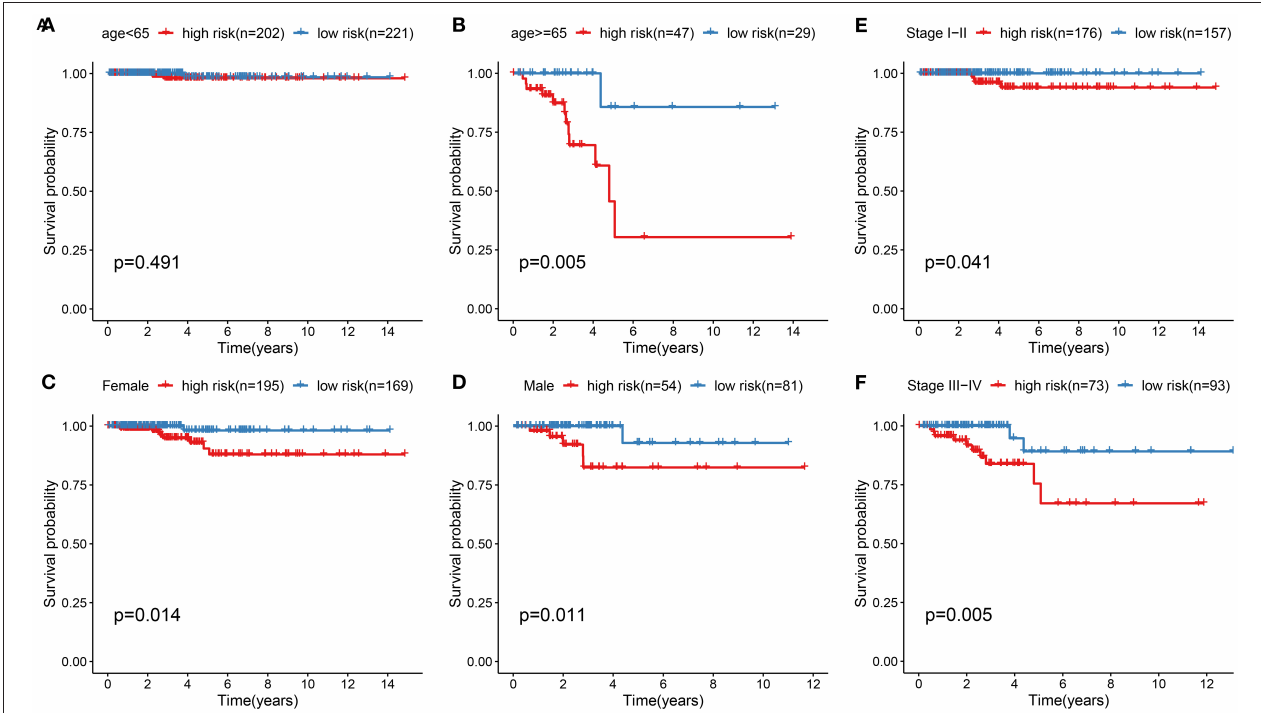
FIGURE 4 | Stratified analysis for the predictive efficacy of the ferroptosis-related model among thyroid cancer samples. (A,B) Kaplan-Meier curves for high and low risk group in the two subgroups of age < 65 and age ≥ 65. (C,D) Kaplan-Meier curves for high and low risk group in the two subgroups of female and male. (E,F) Kaplan-Meier curves for high and low risk group in the two subgroups of stage I-II and stage III-IV.